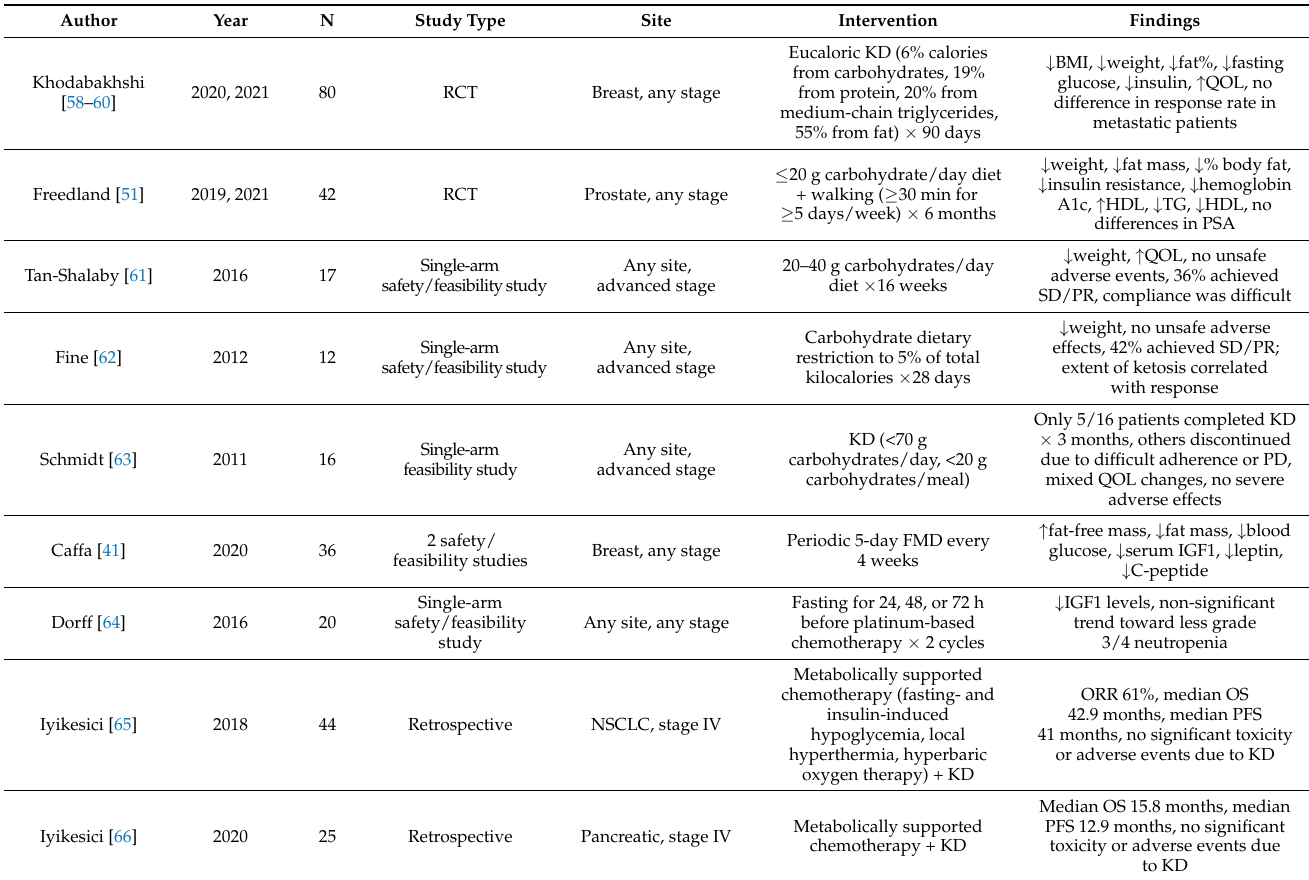
Table 2. Summary of clinical studies testing insulin-lowering dietary strategies that included patients with advanced or metastatic